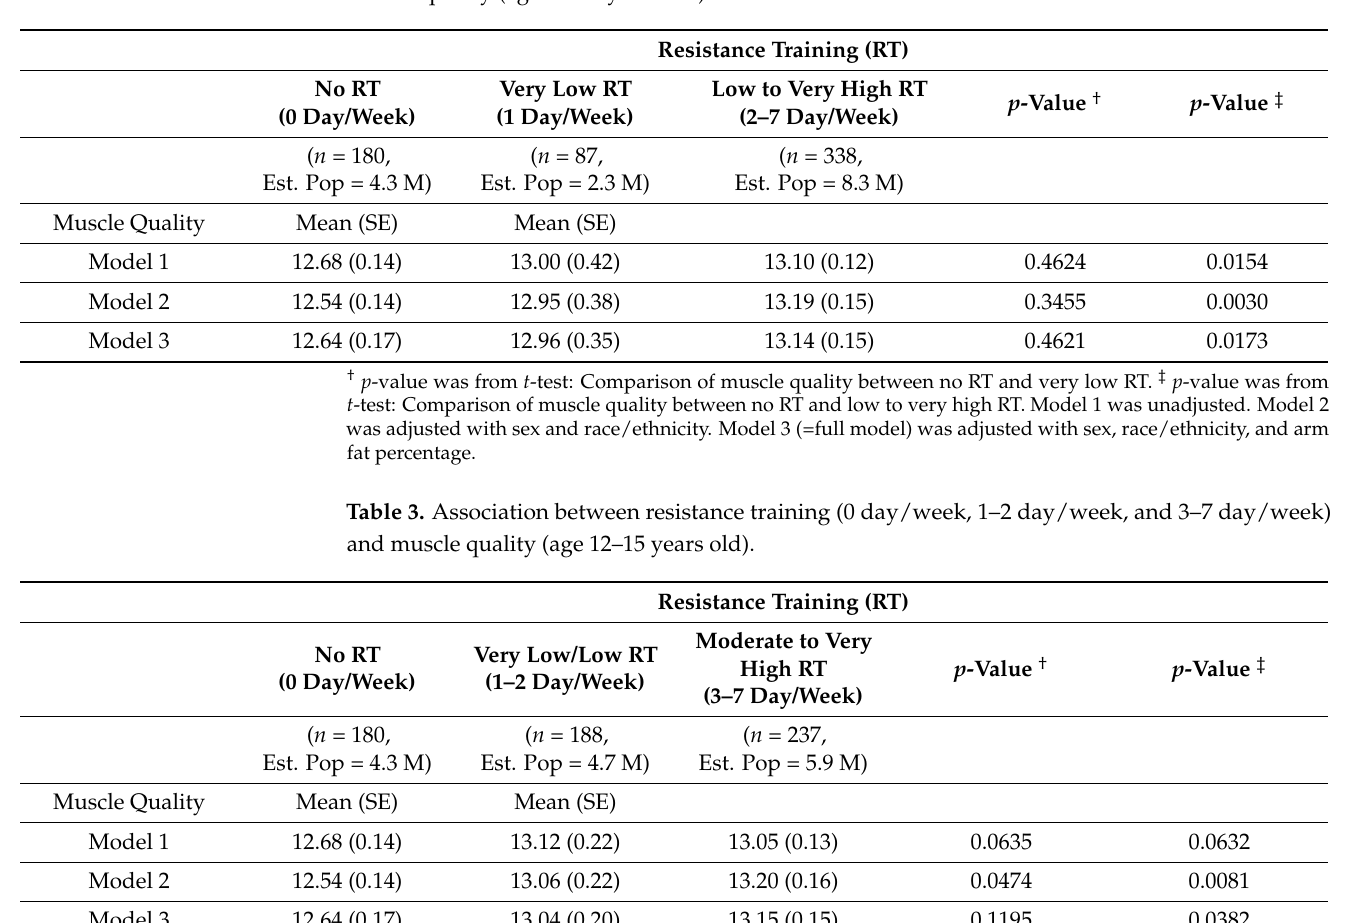
Table 2. Association between resistance training (0 day/week, 1 day/week, and 2–7 day/week) and muscle quality (age 12–15 years old).